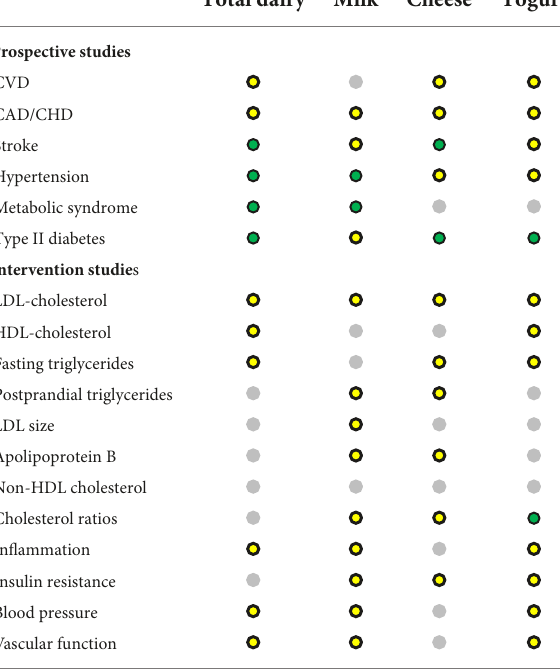
TABLE 3 Summary of the systematic reviews and meta-analyses between dairy foods and various cardiometabolic disease risk parameters a [adapted from Gille et al.